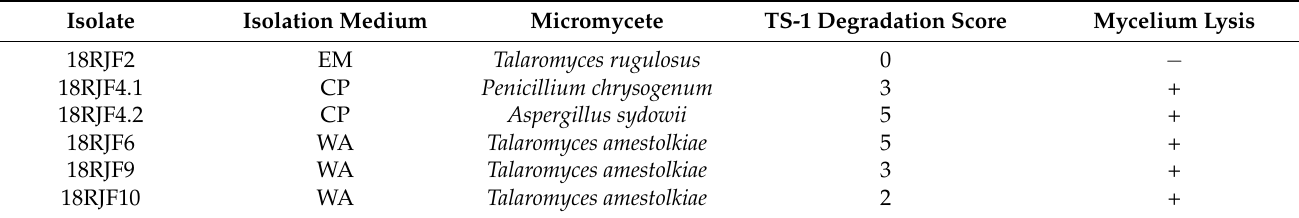
Table 2. Characteristics of micromycetes isolated from the TS-1 jet fuel: sample isolation medium, micromycete species based on microscopic observation. degradation score of the TS-1 jet fuel scored as: 0 points—no growth; 1 point—cloudy solution, very small flakes; 2 points—flakes of medium size, easily distinguishable visually; 3 points—large flakes; 4 points—small clots; and 5 points—large clots. Mycelium lysis in the culture and visual presence of bacteria in the mycelium. EM—Evans medium, CP—Czapek medium, and WA—worth